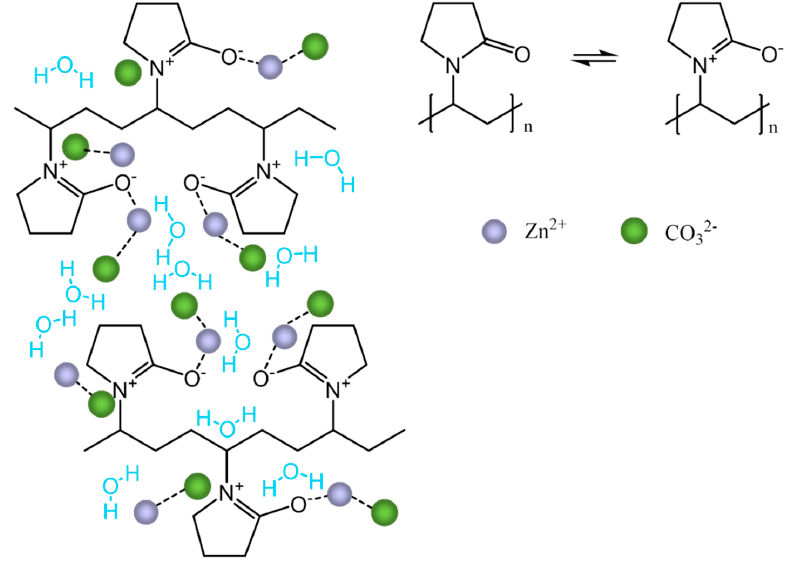
Figure 2. Proposed scheme of the interactions between PVP and the precursor ions.